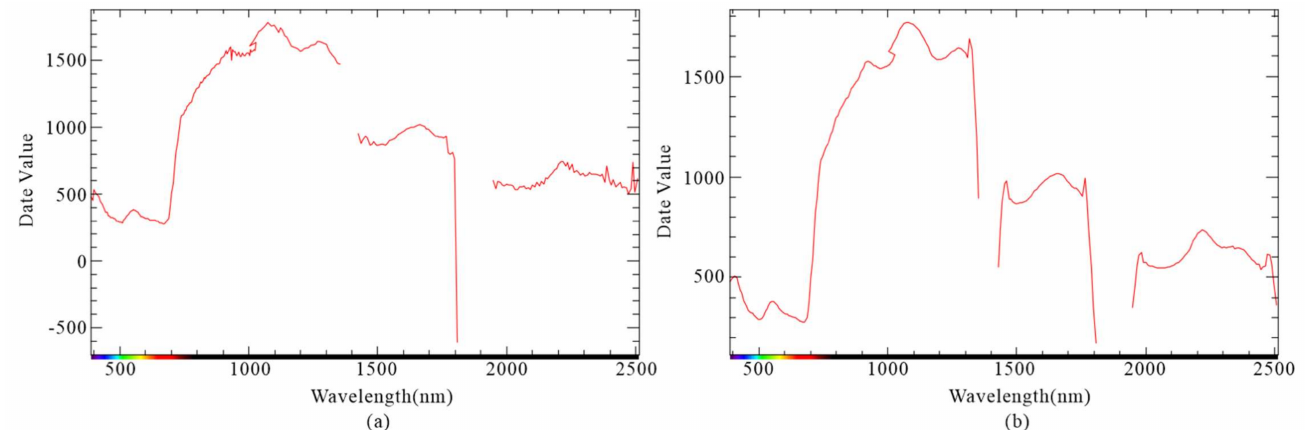
Figure 8. ( a ) Spectral profile after radiometric calibration and FLAASH; ( b ) spectral profile after S-G